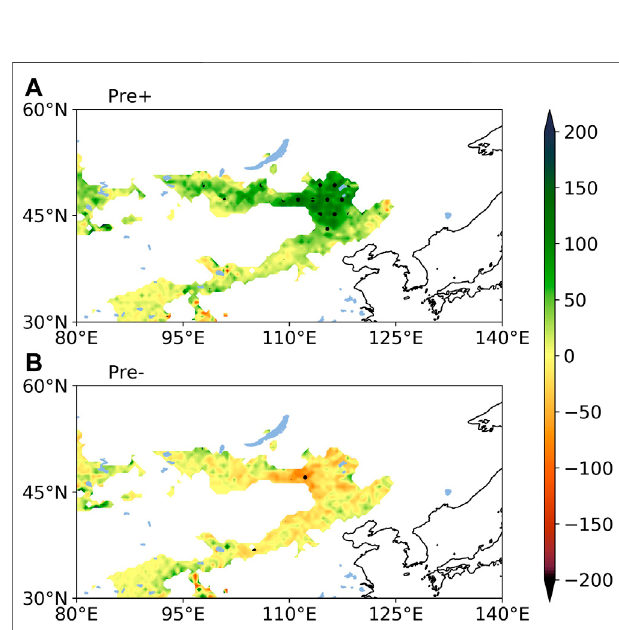
FIGURE 11 | GPP composite for wet (A) and dry (B) years in the semi- arid regions of East Asia (units: g C m − 2 ). Stippling denotes the region with statistical signi fi cance at the 90% con fi dence level based on Student ’ s t-test.